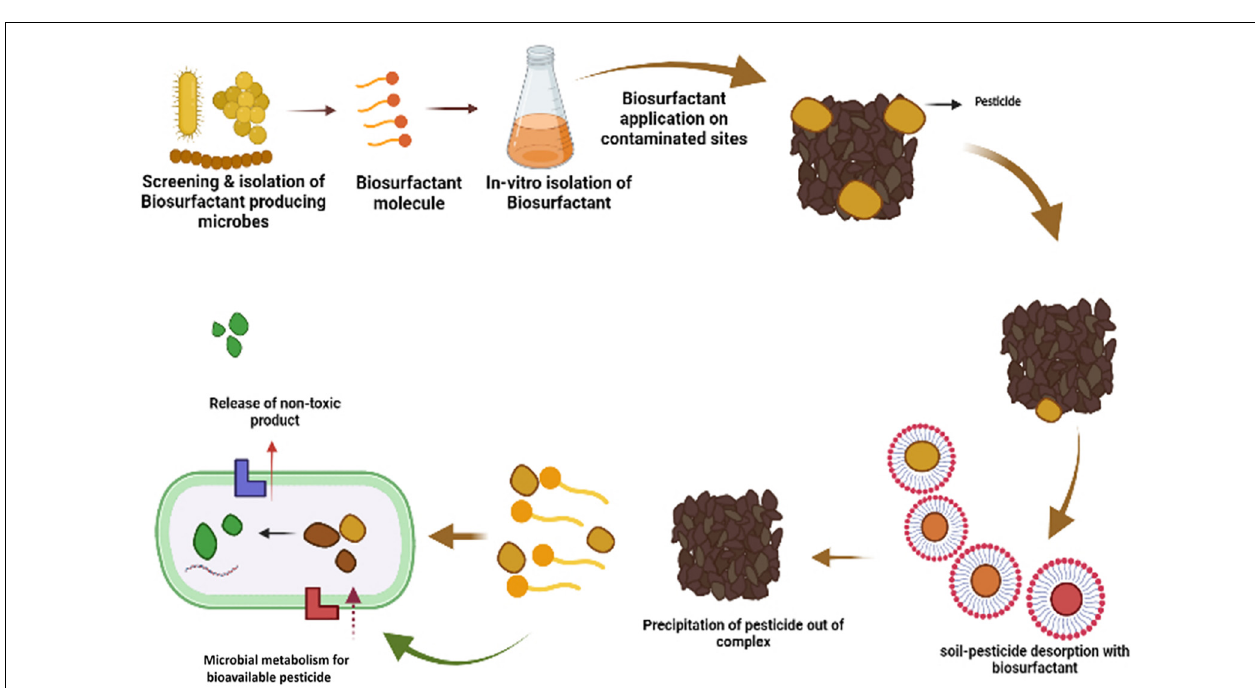
FIGURE 4 | In-vitro isolation of biosurfactant and its application at pesticide-contaminated sites. Further steps indicate the adsorption of biosurfactant with the soil-pesticide complex leading to desorption of pesticides from the soil particles. Microbial surfactants precipitate from the pesticide-biosurfactant complex, making pesticides bioavailable for the microbes for their further